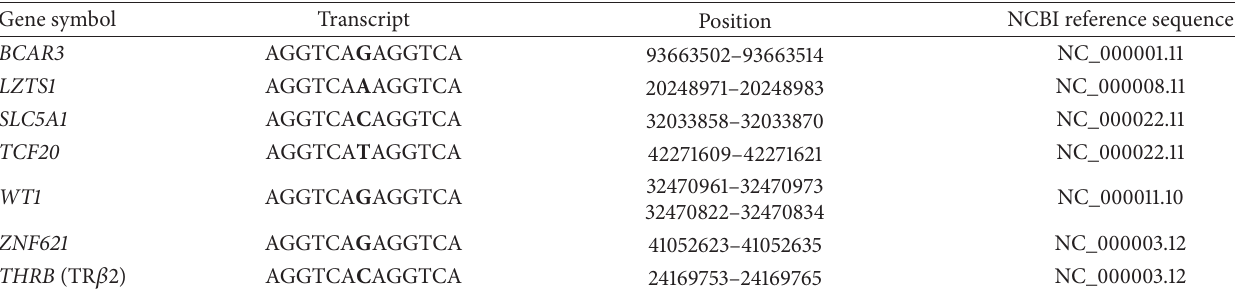
Table 1: Identification of in silico putative PPAR-responsive